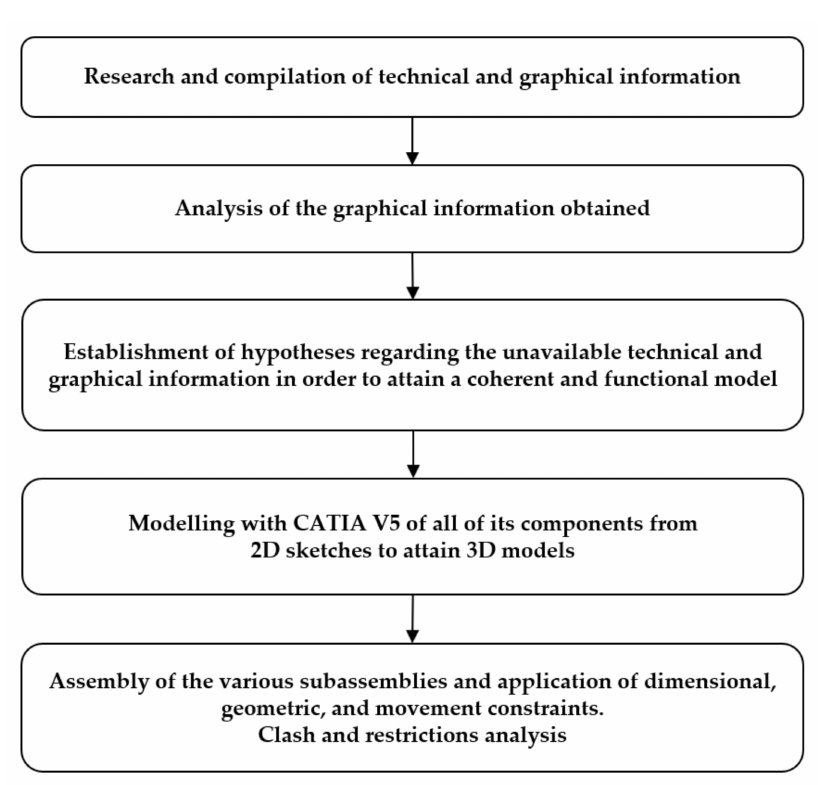
Figure 1. Flowchart of the modelling